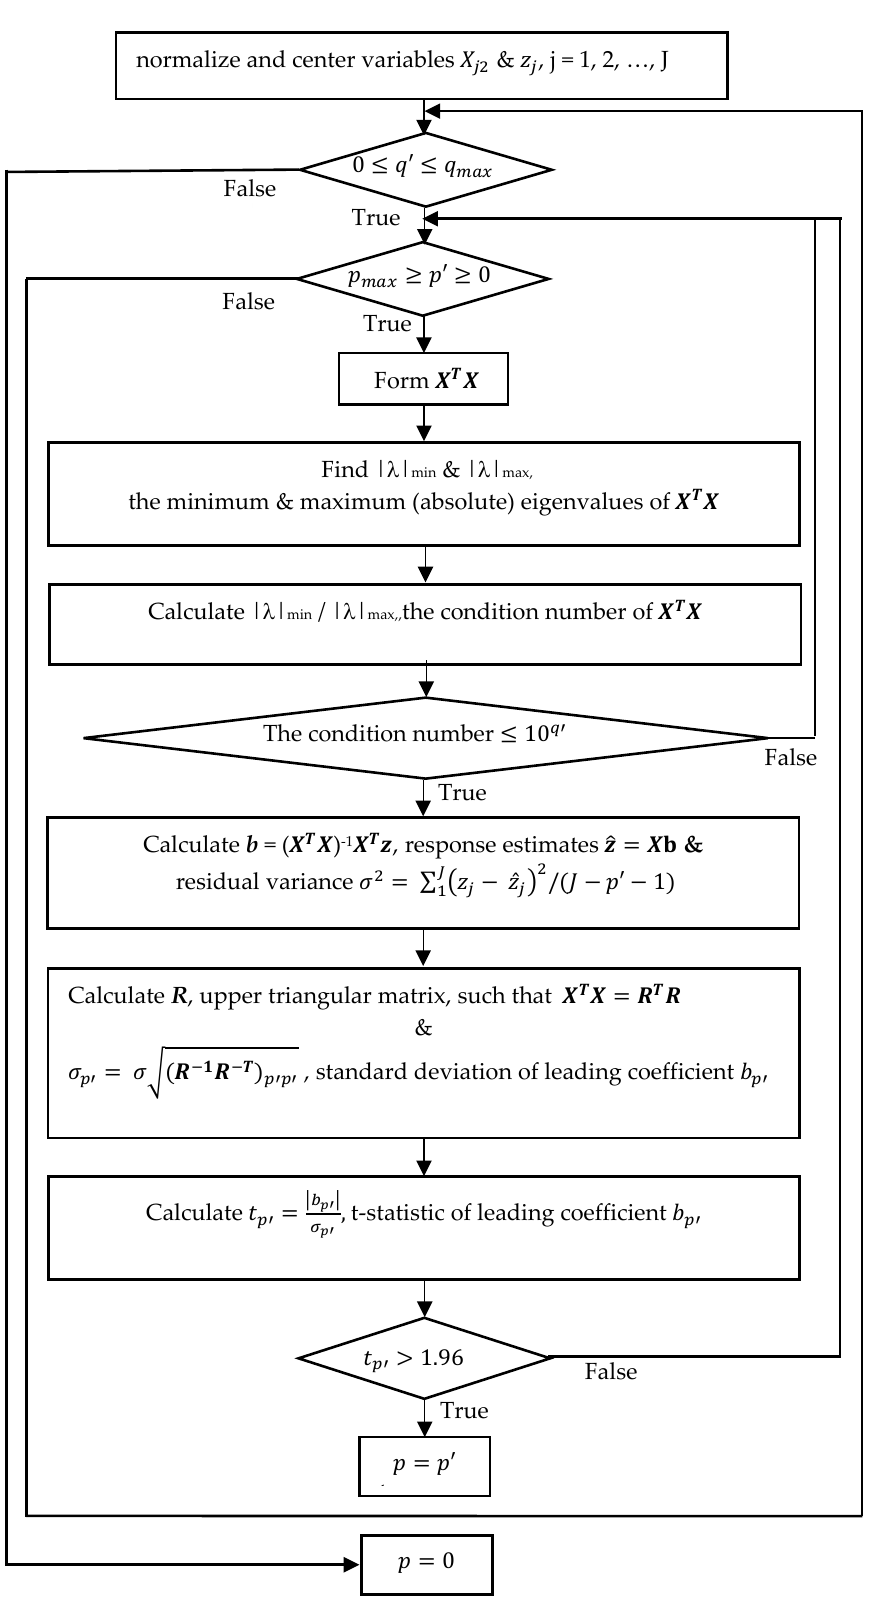
Figure 4. An algorithm for automatic identification of the interpolating